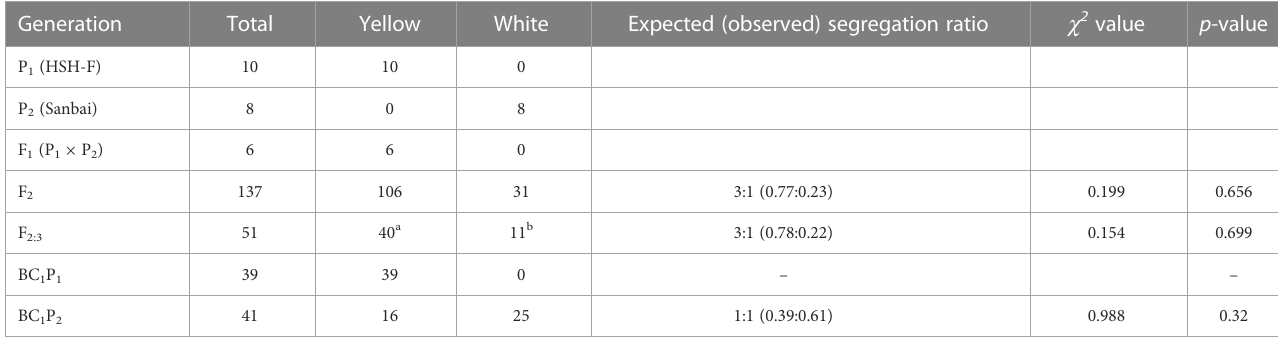
a Fifteen individuals for each family, including all yellow fl esh color or segregated fl esh families b All white fl esh